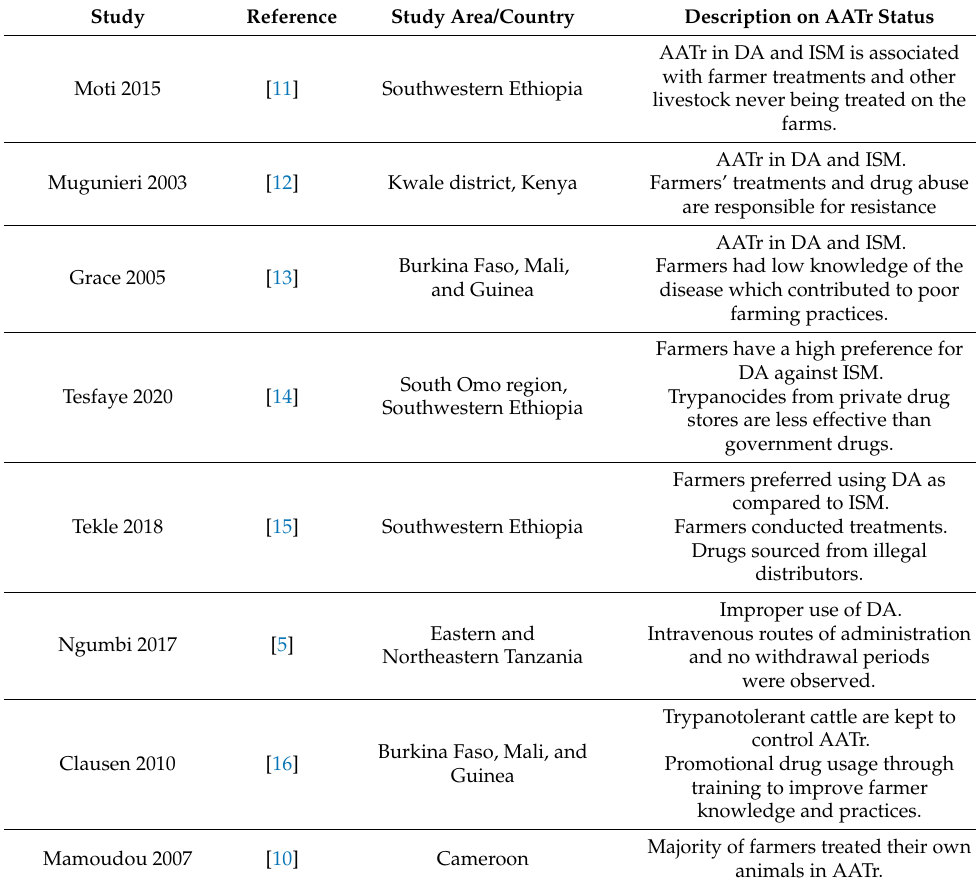
Table 1. Community surveys identified on African animal trypanocide resistance knowledge, atti- tudes, and practices, indicating the study area and resistance